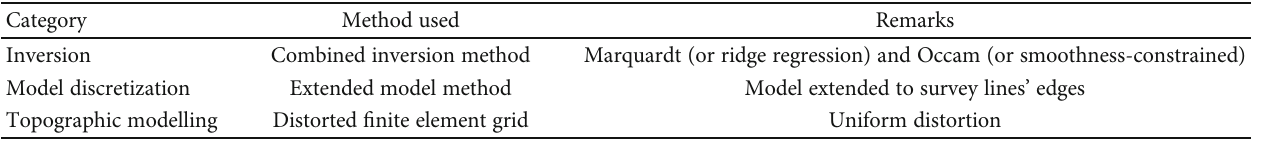
Figure 13: Field electrical resistivity survey in progress along the longitudinal survey line of the Karli spillway. The pictures illustrate (a) the marking of the electrode locations and (b) the resistivity system. Table 2: RES2DINV modelling parameters for the Hattian Bala landslide